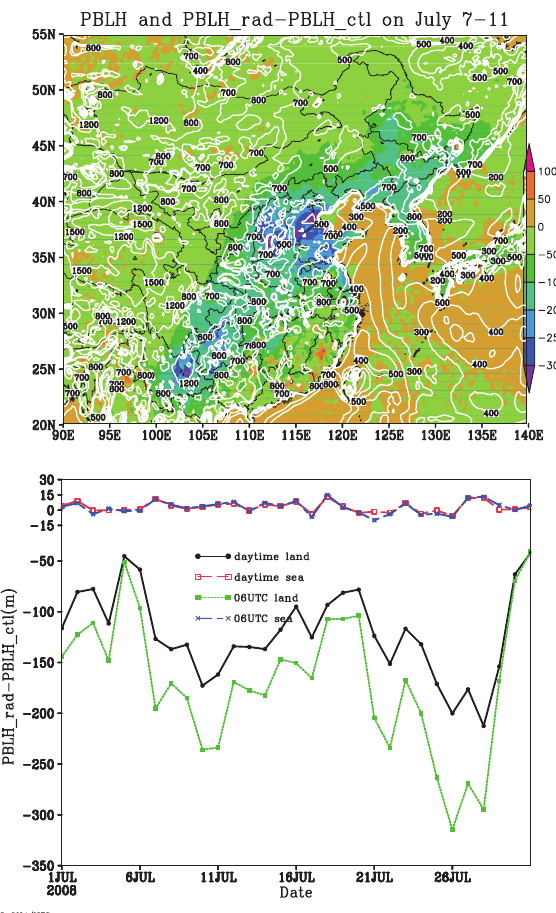
Figure 4. FKTM change (m 2 s − 1 ) due to aerosol DRF: (a) mean FKTM by the CTL experiment (shaded) and FKTM difference be- tween the RAD and CTL experiments (contour) during 7–11 July; (b) daily changes of LAND- and SEA1-averaged FKTM difference between the RAD and CTL experiments at the surface from 1 to 31 July.